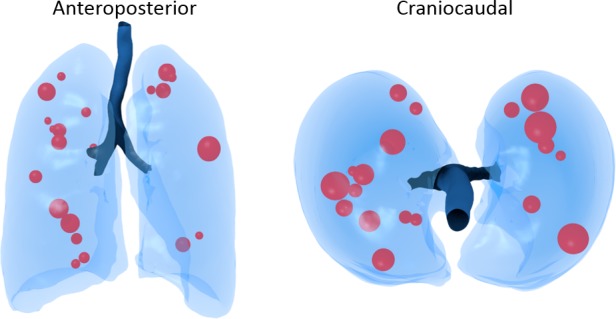
3D model of the lungs with the lesions (size and location) measured from the CT scans.